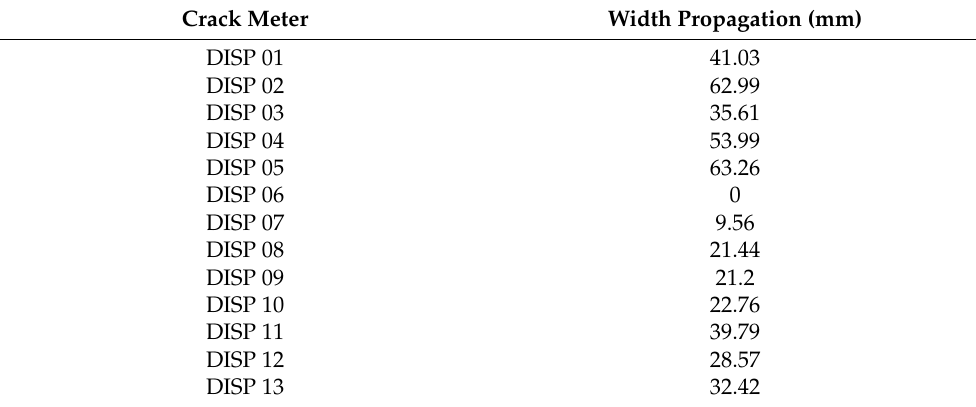
Table 3. Record of the crack